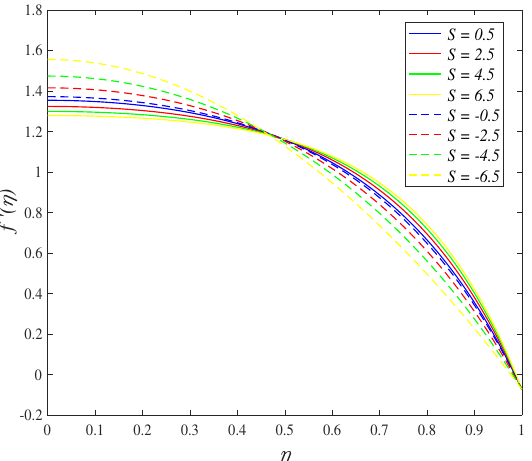
Figure 3. Impact of S on axial velocity.